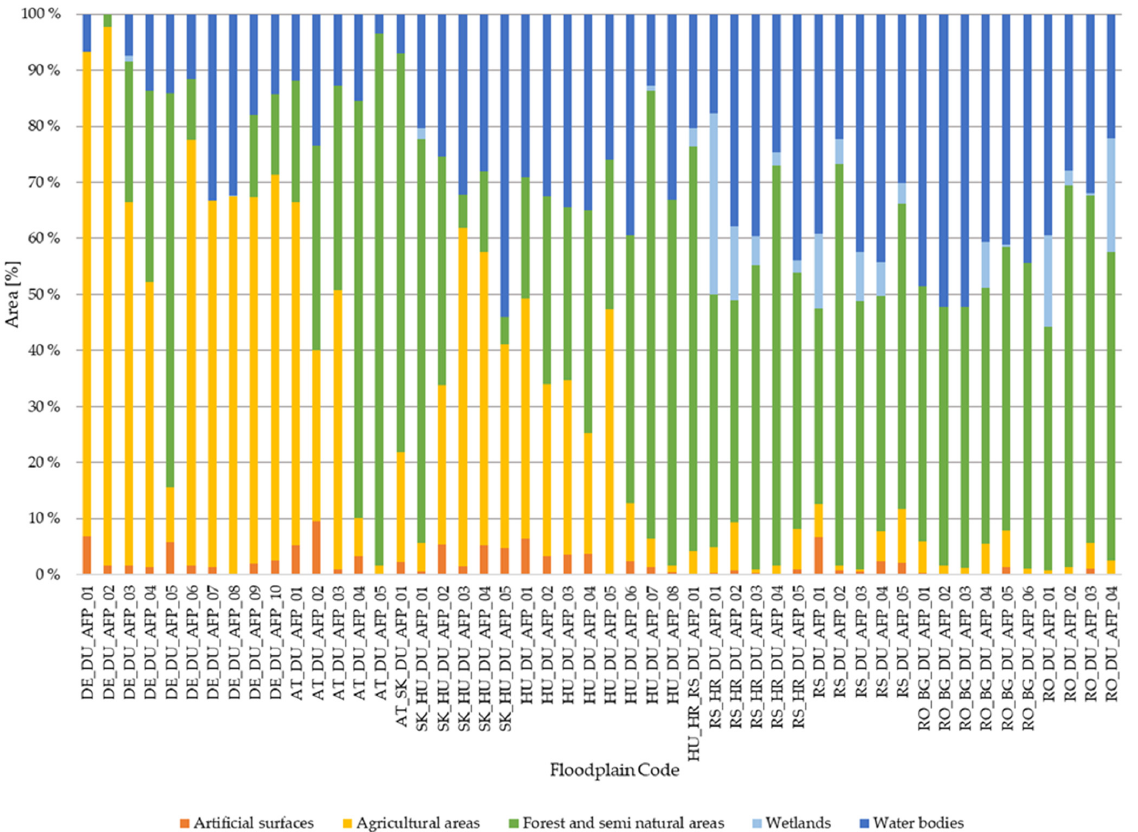
Figure 6. Area distribution of active Danube floodplains (> 500 ha) from up- to downstream.